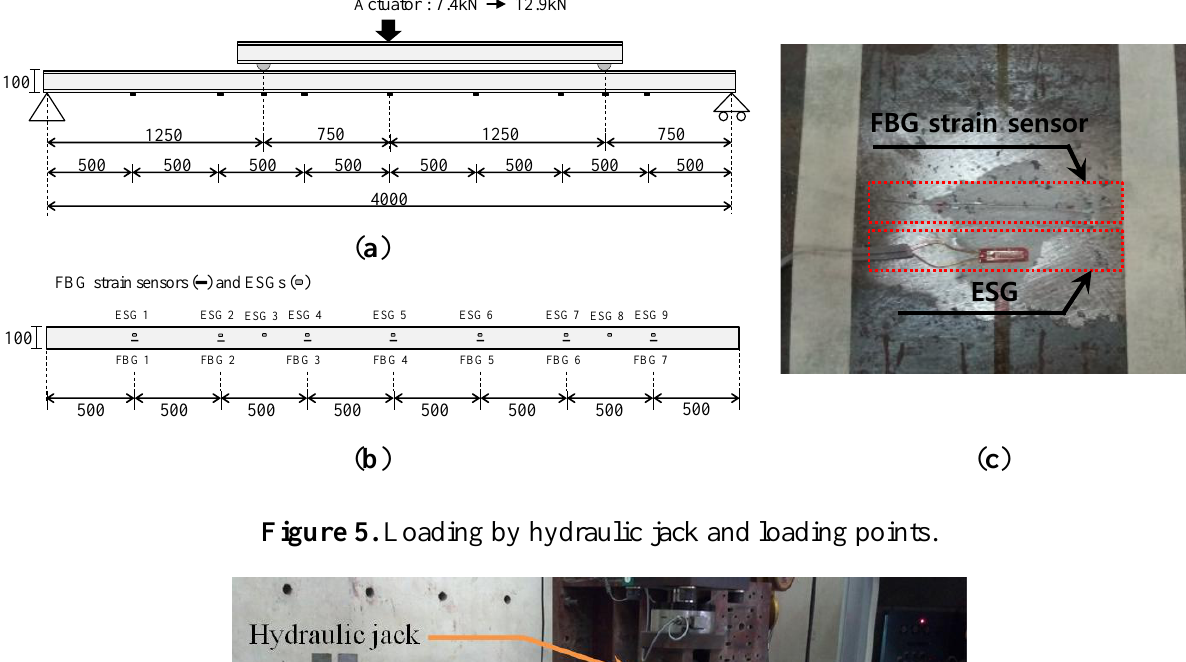
Figure 4. Experimental setup. ( a ) Side view. ( b ) Bottom view. ( c ) Installation of fiber Bragg grating (FBG) sensors and electrical strain gages (ESGs).